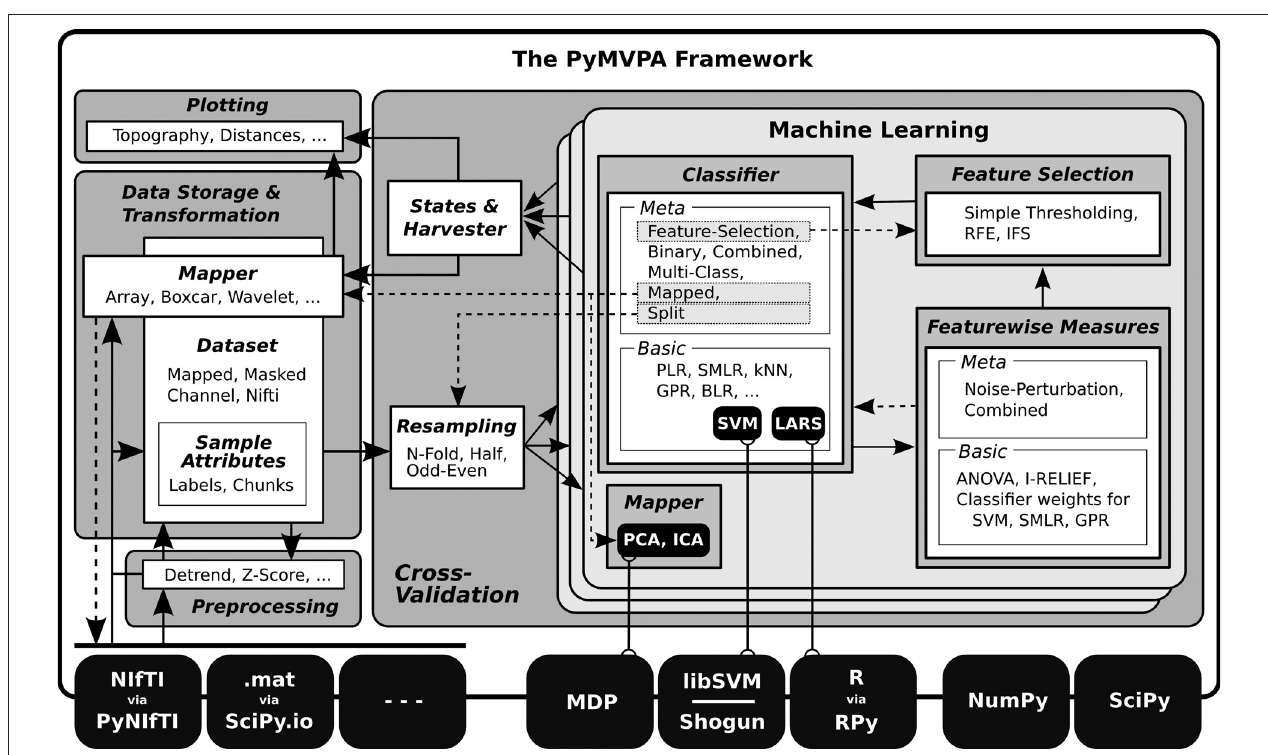
functionality provided by external software packages (black boxes). In the case of SVM , classifi ers are interfaced to the implementations in Shogun